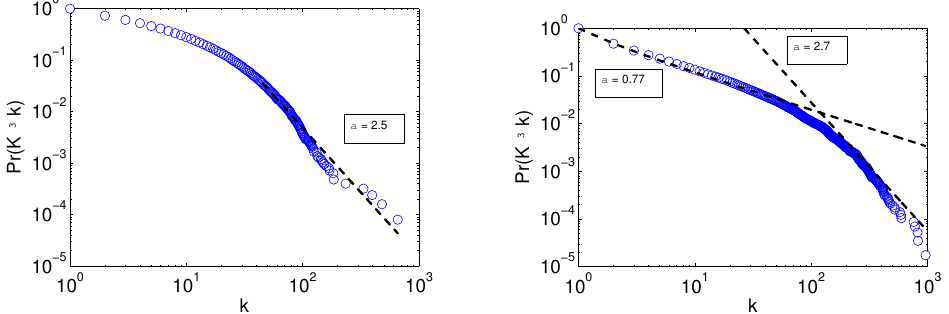
Figure 5. Cumulative degree distributions P cum ( k ) of Communities ( left panel ) and VirtualTourist ( right panel ). k is the degree, and α is the coefficient of the fitting (dashed) line k − α . The Figure clearly shows a power law behavior in the degree and α is approximately equal to 2.5 and 2.7, respectively.